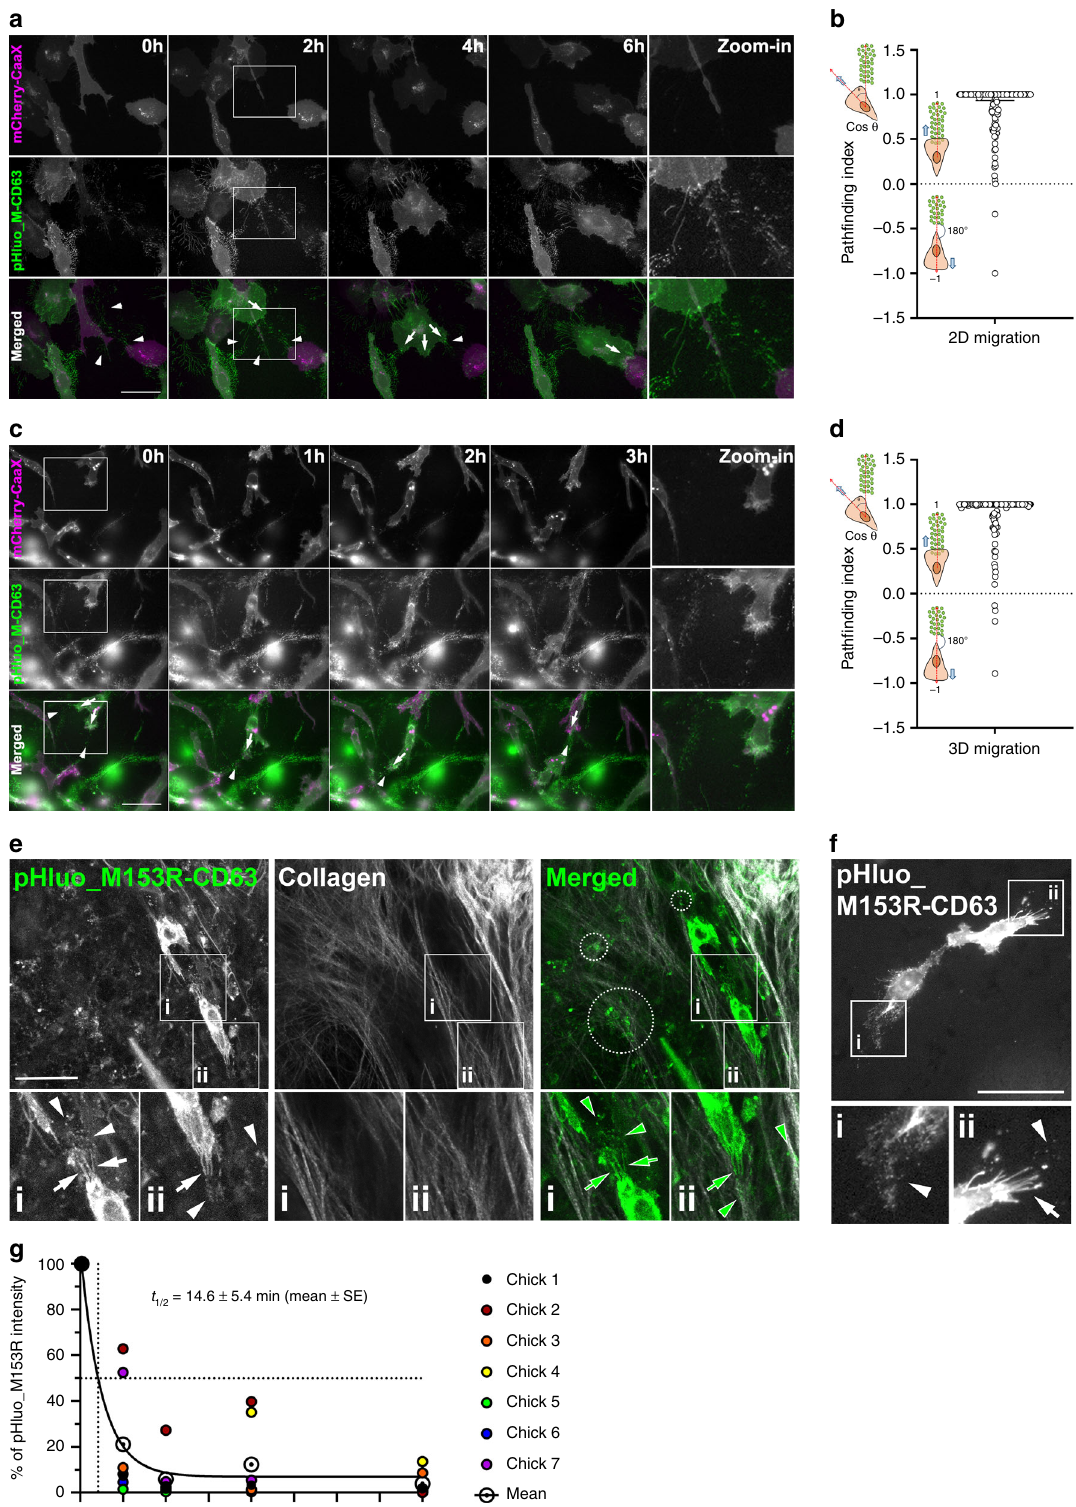
terminus of CD63 and the N-terminus of mScarlet. To determine whether the C-terminal mScarlet tag interferes with CD63 traf fi cking, we performed immuno fl uorescence for several late endosomal/lysosomal markers and analyzed the effect of the tag on colocalization (Fig. 6). Comparing the localization